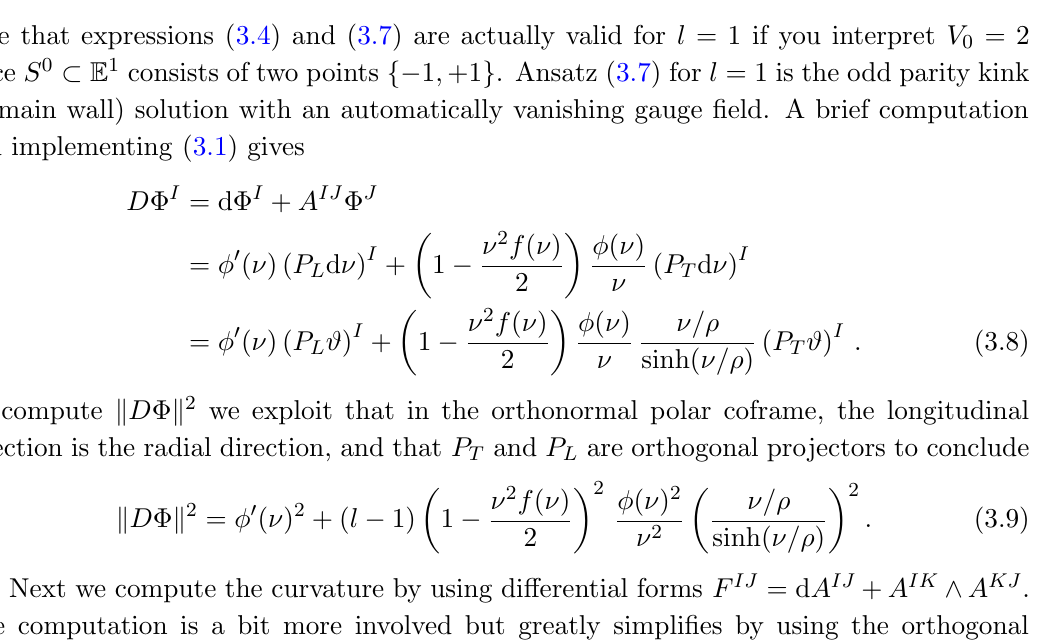
Figure 2 . Here U is a typical symmetry breaking potential with minima at without justi(cid:12)cation that U ( (cid:30) 0 ) =